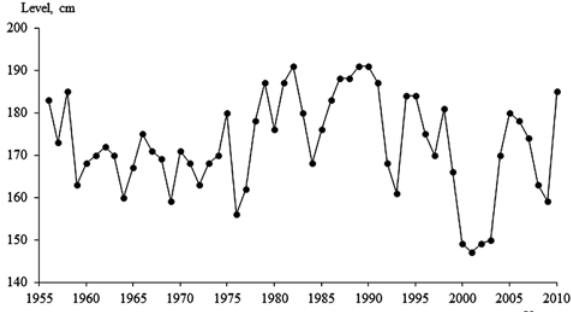
fig. 2. The fluctuations of the level in lake naroch,